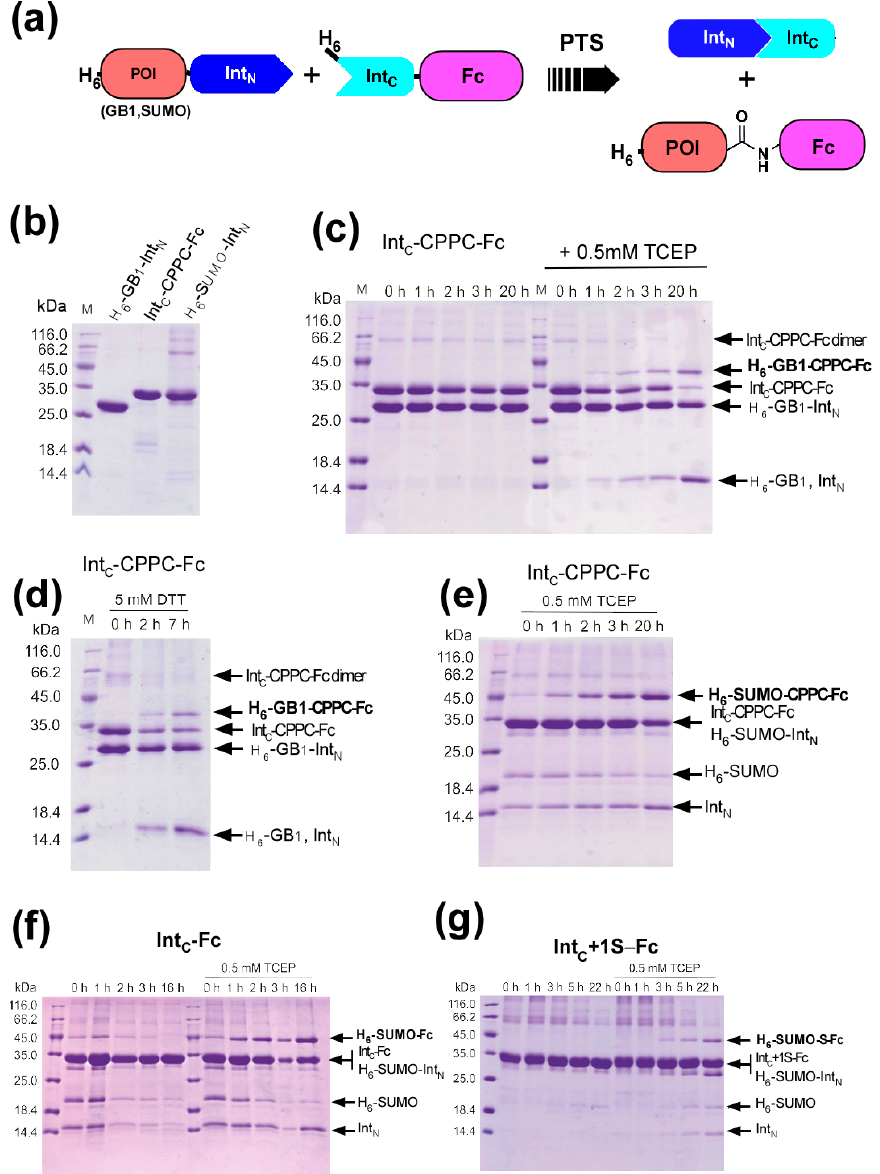
Figure 5. In vitro Fc fusion by PTS ( a ) Schematic drawing of the ligation of model proteins (SUMO and GB1) with the C-terminal Fc domain by PTS. ( b ) SDS-PAGE analysis of the N- and C-terminal precursor proteins (H 6 -GB1-Int N , Int C -CPPC-Fc, and H 6 -SUMO-Int N ) independently purified by IMAC. ( c ) Time course of the ligation reaction between H 6 -GB1-Int N and Int C -CPPC-Fc in the absence (left panel) or presence (right panel) of 0.5 mM TCEP. Samples were taken after 0, 1, 2, 3, and 20 h of incubation, and analyzed by SDS-PAGE. ( d ) The e ff ect of 5 mM DTT instead of 0.5 mM TCEP was tested for the reaction mixture of H 6 -GB1-Int N and Int C -CPPC-Fc. Samples were analyzed by SDS-PAGE after 0, 2, and 7 h of incubation. ( e – g ) Comparison between the three Fc constructs (Int C -CPPC-Fc ( e ), Int C -Fc ( f ), and Int C + 1S-Fc ( g )). Protein ligation with H 6 -SUMO-Int N was analyzed with and without 0.5 mM TCEP by SDS-PAGEs. Incubation times in hours (h) are indicated above the lanes of